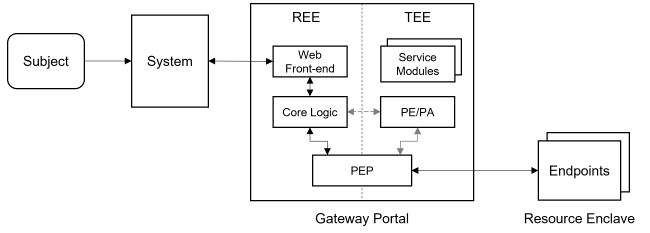
Figure 9. Gateway portal model applied to the Edge